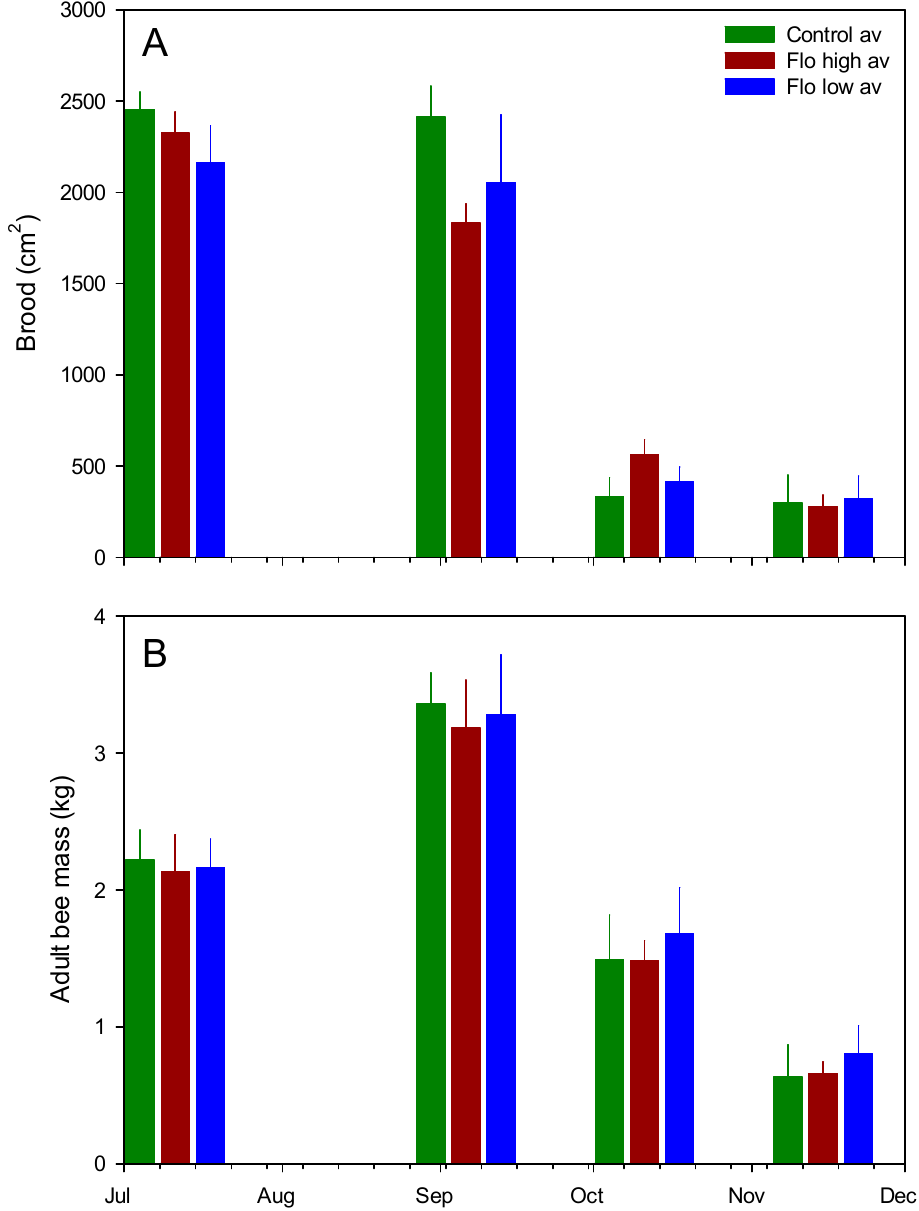
Figure 3. Mean (SE) colony measures across treatment groups. ( A ) Brood surface area; ( B ) adult bee mass.